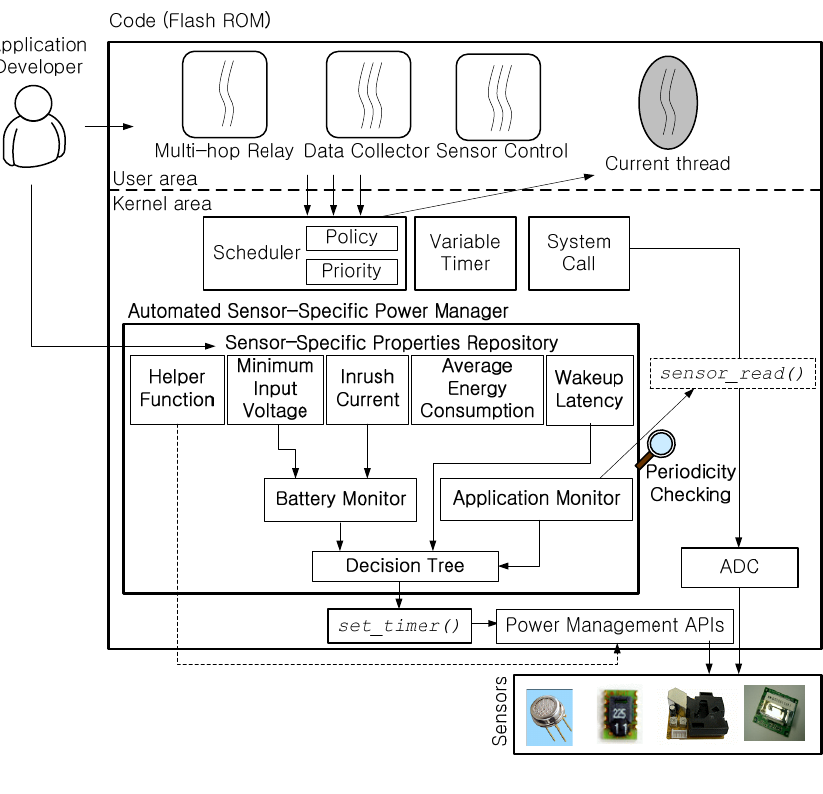
Figure 4. Software architecture of APOLLO on